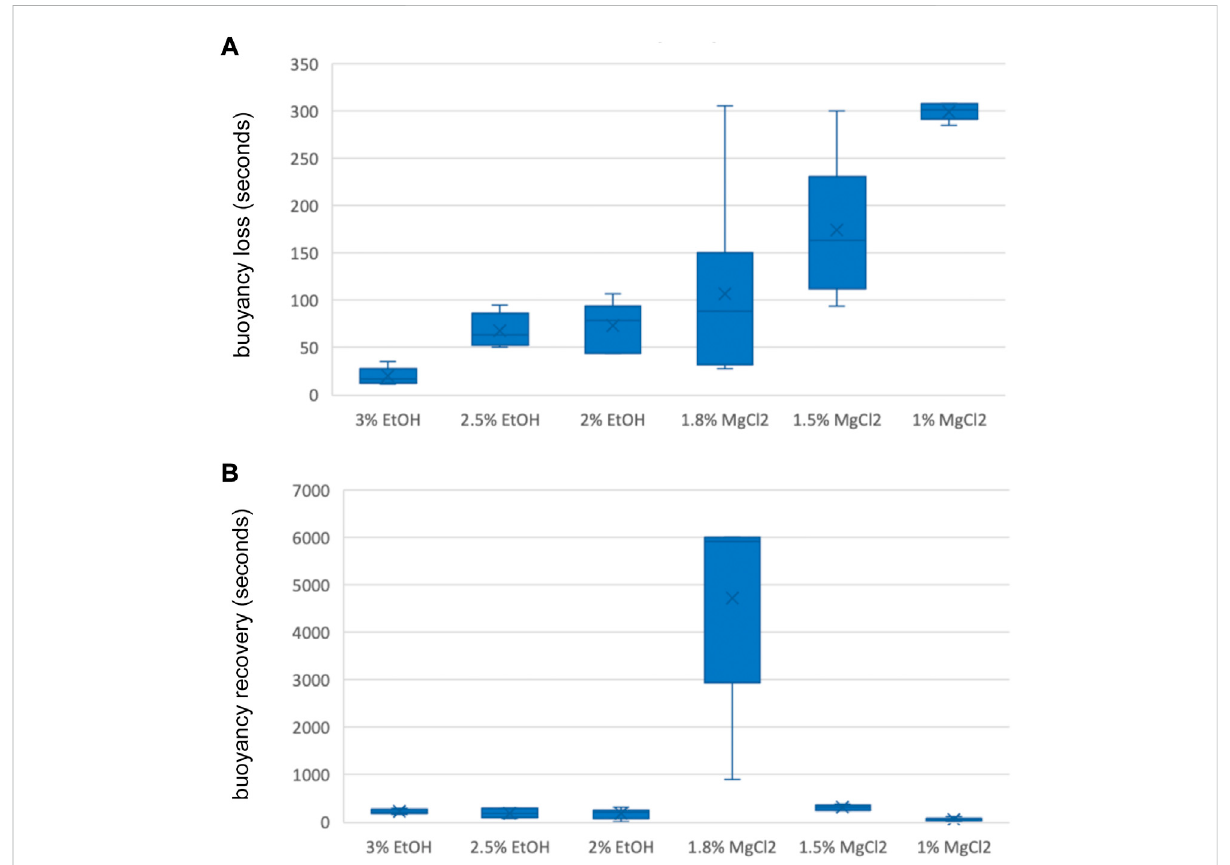
FIGURE 4 (A) Boxandwhiskersplotwiththetimeuntillossofbuoyancyresponseinseconds.They-axisrepresentsthesecondsuntillossofbuoyancyand the x-axis displays the three EtOH and MgCl 2 concentrations. The upper and lower limits show the highest and lowest times, respectively, until the loss of buoyancy, and the mid-point shows the mean. (B) Box and whiskers plot with the time to recovery of buoyancy response in seconds. The y-axis represents the seconds to the recovery of buoyancy and the x-axis displays the three EtOH and MgCl 2 concentrations. The upper and lower limits show the highest and lowest times, respectively, until recovery of buoyancy, and the mid-point shows the